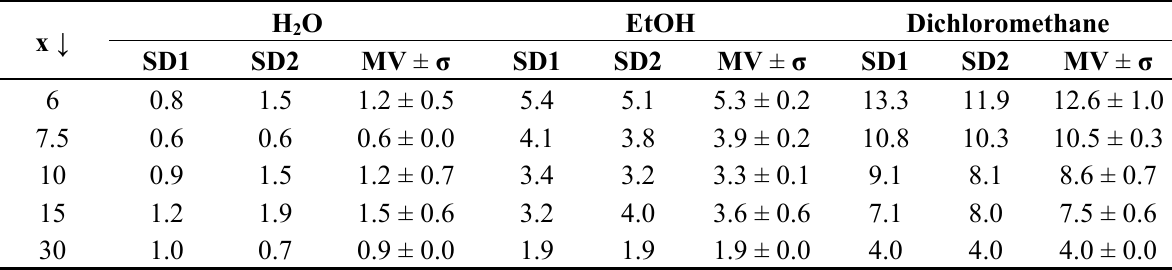
Table 3. The swelling degrees of p EtOx water, ethanol and dichloromethane. The swelling degrees according to ( m were determined in duplicate [SD1 and SD2, respectively; the average is represented by the arithmetic mean value (MV) and the standard deviation, σ